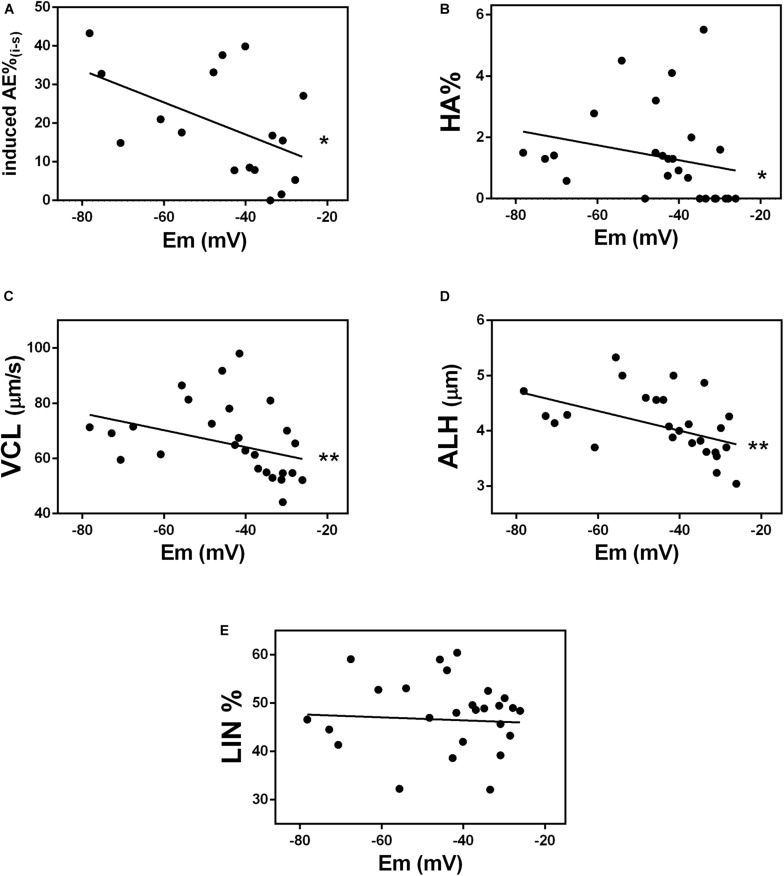
Membrane potential correlates with events related to capacitation. Correlation between absolute values of membrane potential (Em) of donor sperm incubated in HTF non-commercial capacitating media and the following: (A) acrosomal exocytosis (AE) induced by 10 μM A23187 (∗P = 0.0366); (B) hyperactivated motility (HA%) (r = –0.4865, ∗P = 0.0101); (C) curvilinear velocity (VCL) (r = –0.5000, ∗∗P = 0.0079); (D) lateral head displacement (ALH) (r = –0.5497, ∗∗P = 0.0030), and (E) linearity coefficient (LIN) (r = –0.0464, P = 0.8182).